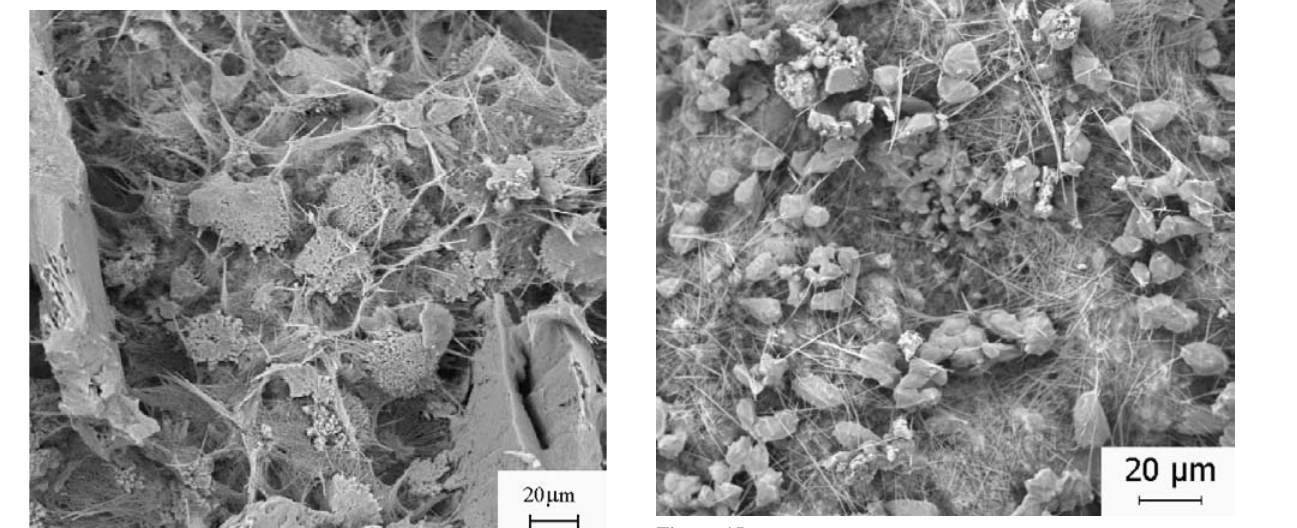
Figure 15. SEM micrograph of anhydrate crystals on the (L) samples (CPII-Z-32 cement/sand/5% grit) after 28 days of